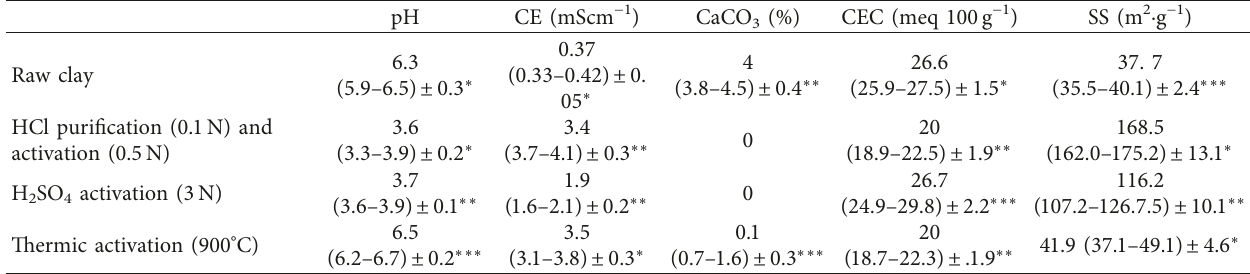
Figure 5: SEM image showing luminous crystals on raw clay (AB) surface (a) and energy-dispersive X-ray analysis (EDS) of point 2 (b). Table 3: Statistic values of the maximum physicochemical parameters of raw and obtained clay by purification and activation of Sejnane clay type in different solution normalities and